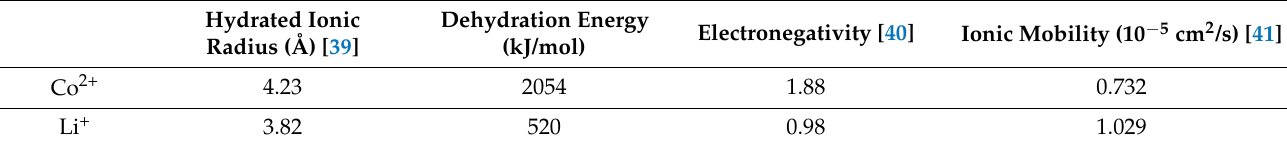
Table 4. Properties of Co 2+ and Li + in aqueous